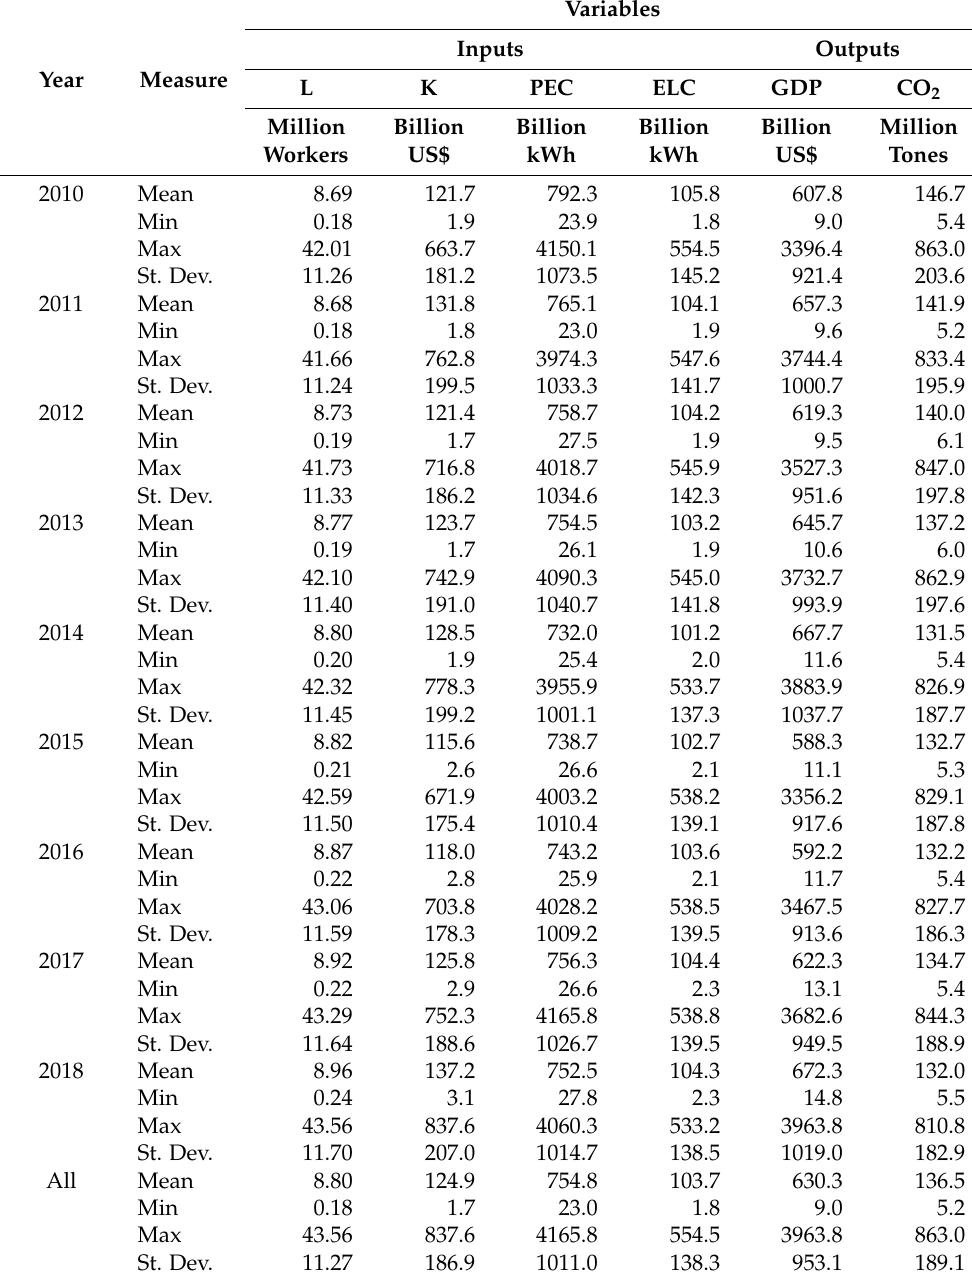
Table A3. Summary statistics for the variables used in the DEA model over